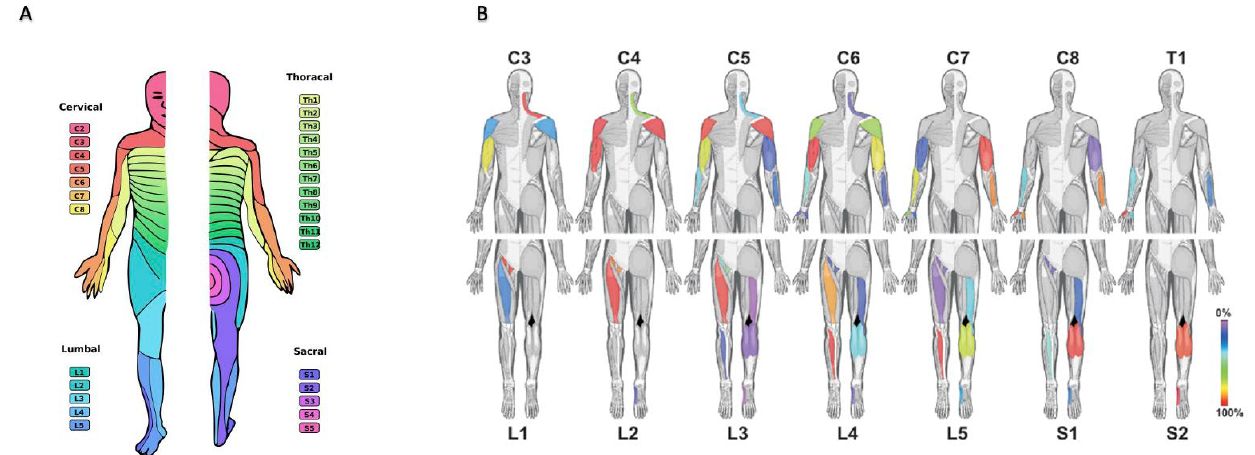
Figure 2. Overview of the Dermatomal and Myotomal Innervations of the Spinal Nerves. ( A ) Diagram of the respective dermatomal distributions for the 31 pairs of spinal nerves as they travel along their distinct paths from posterior to anterior [15]. ( B ) Myotomal distributions of the lumbosacral spinal nerves. The muscle groups are color-mapped to reflect the rate of response upon individual intraoperative nerve root stimulation [16]. Adapted from Whitman et al. and Schirmer et al. [15,16].